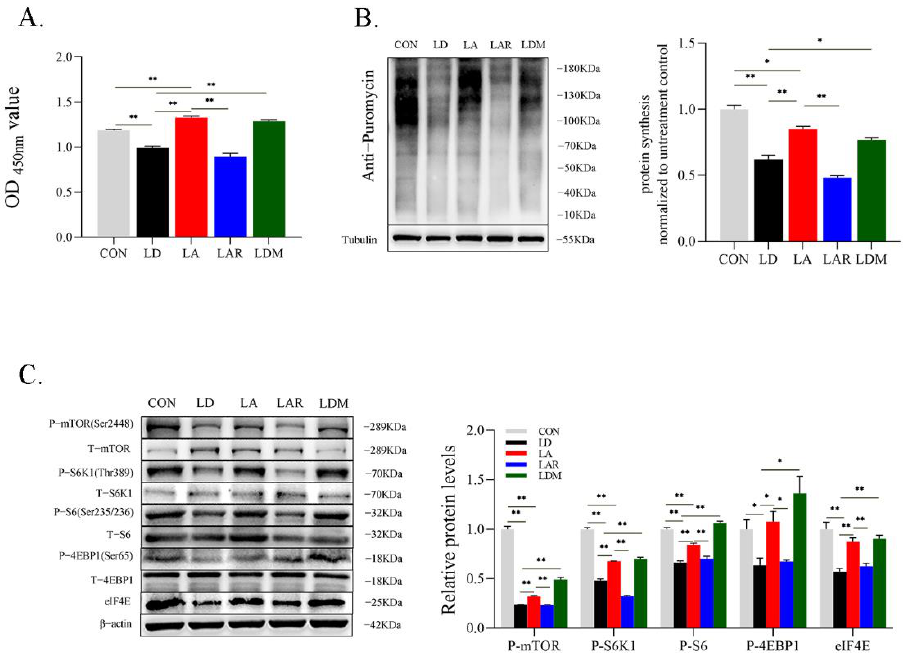
Figure 6. mTORC1 signaling pathway is involved in the regulation of SCs proliferation and protein synthesis by lysine. ( A ) Cell proliferation; ( B ) representative images of cell protein synthesis levels with Western blotting; ( C ) representative images of phosphorylation levels of mTORC1 signaling pathway-related proteins with Western blotting. * p < 0.05, ** p < 0.01. The data shown represent mean ± SEM of three independent experiments ( n = 3).